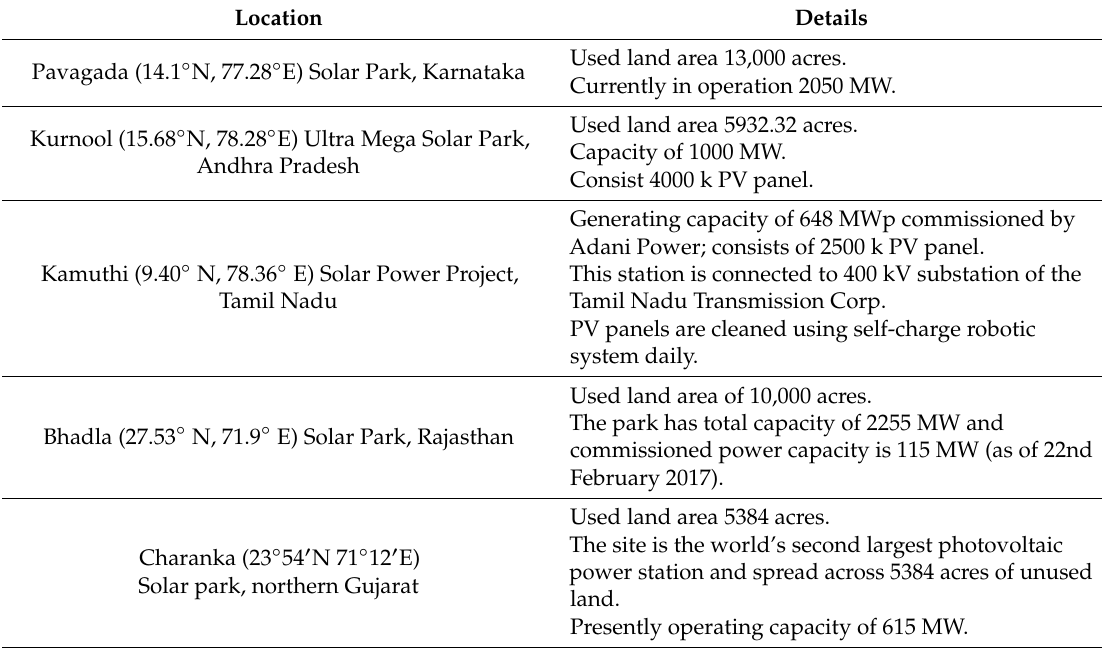
Figure 5. ( a ) Physical map of Indian solar radiation [150]; ( b ) state-wide installed solar rooftop PVs in India [151]. Table 2 indicates India’s major PV installations in five di ff erent states. All the major installations are commissioned in the western, central, and southern parts of India. Table 2. Details of India’s major PV